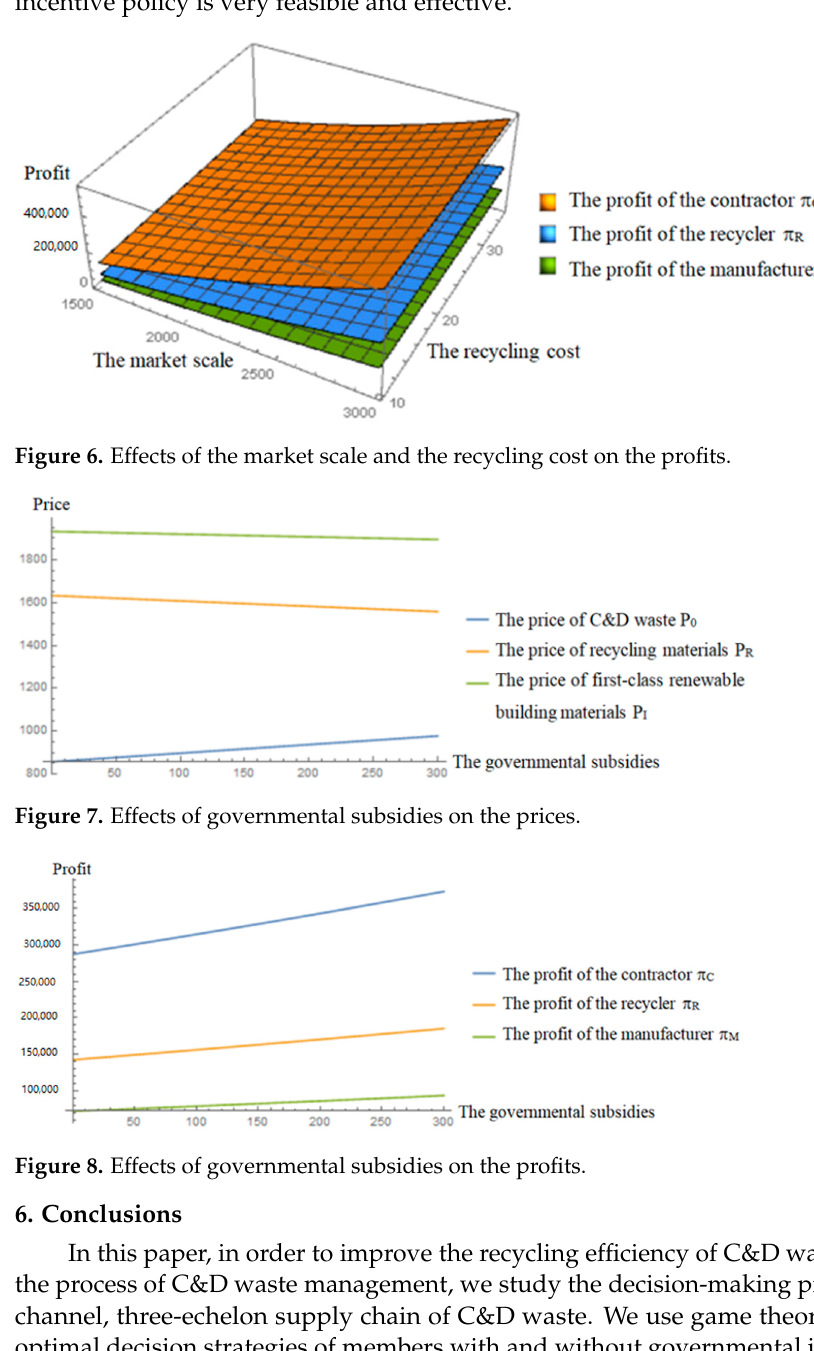
Figure 5. Effects of the market scale and the recycling cost on the prices.